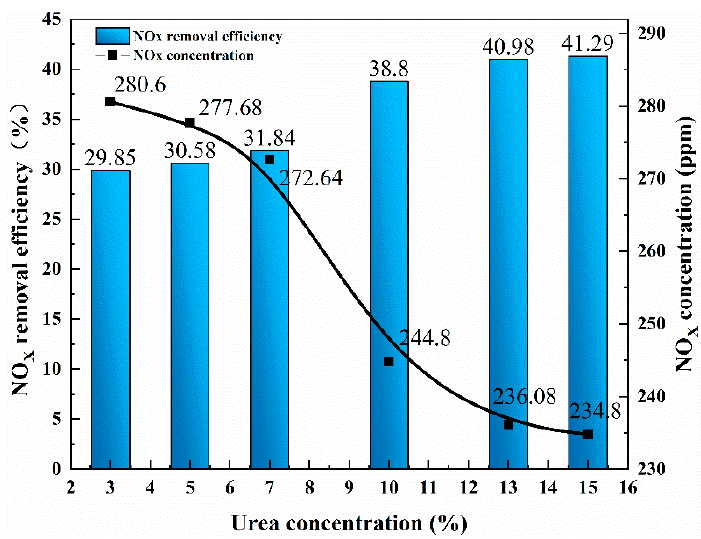
Figure 3. NO X removal efficiencies of urea with different concentrations.